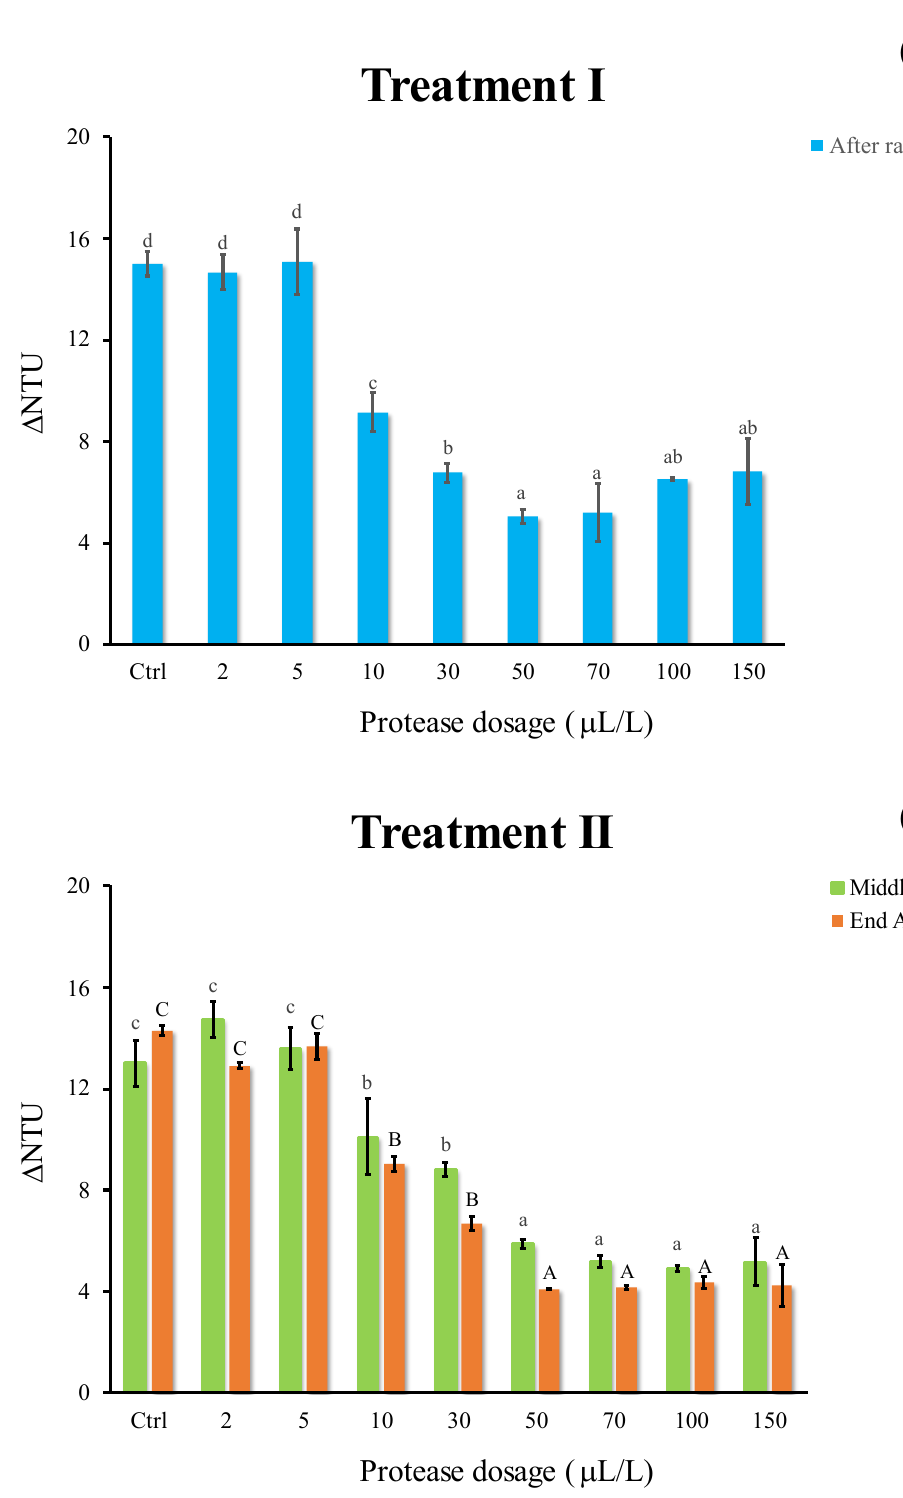
Figure 3. Haze potential of white must wine ( ∆ NTU) subjected to enzymatic addition (protease in the range of 2–150 µ L/L) after ( a ) treatment I (cold settling prior to AF) and ( b ) treatment II (at yeast inoculum). Ctrl is clarified must with the only pectinolytic enzyme. For each sample, means with different roman letters are significantly different ( p ≤